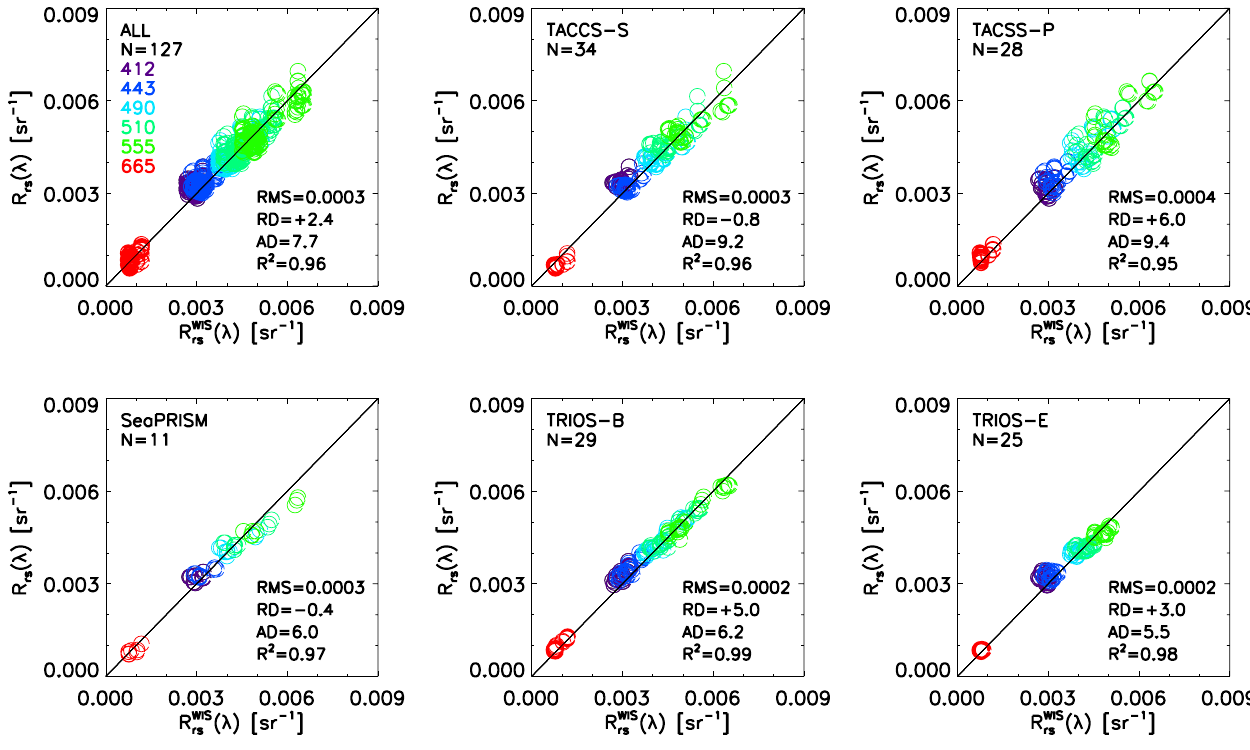
Fig. 4. As in Fig. 2 but for R rs (λ)